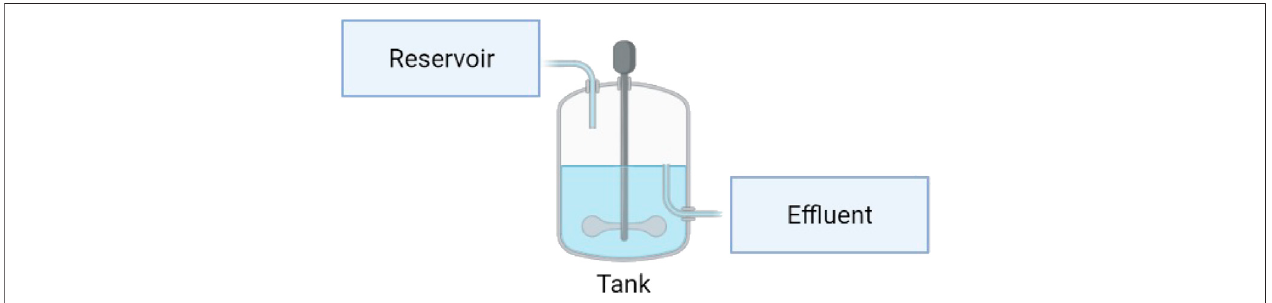
FIGURE 3 | Sketch of a bioreactor in continuous culture mode. The nutrient supply and the removal of toxic and cell products are executed at the same time uninterruptedly. The three main compartments are: reservoir, tank and ef fl uent.